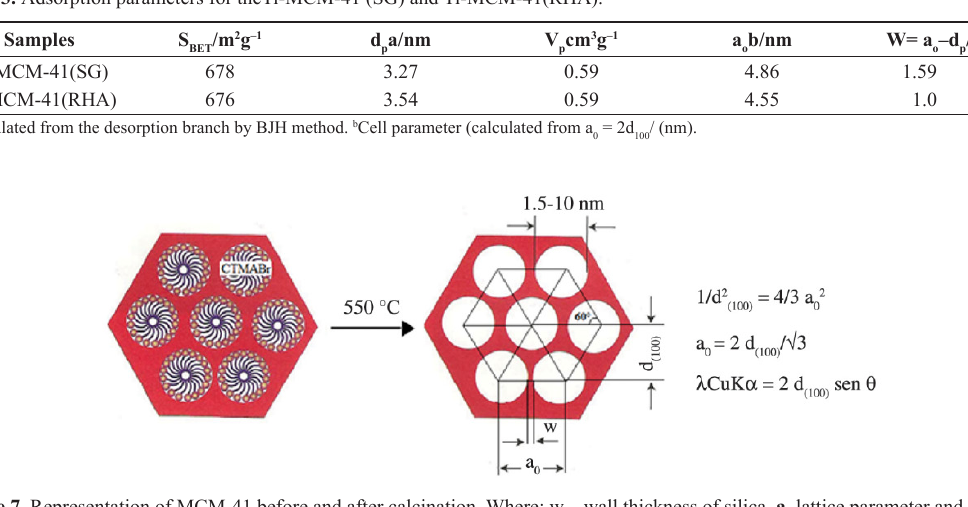
Figure 7. Representation of MCM-41 before and after calcination. Where: w – wall thickness of silica, a interplanar distance to plane 100. Figure from Braga et al. 10